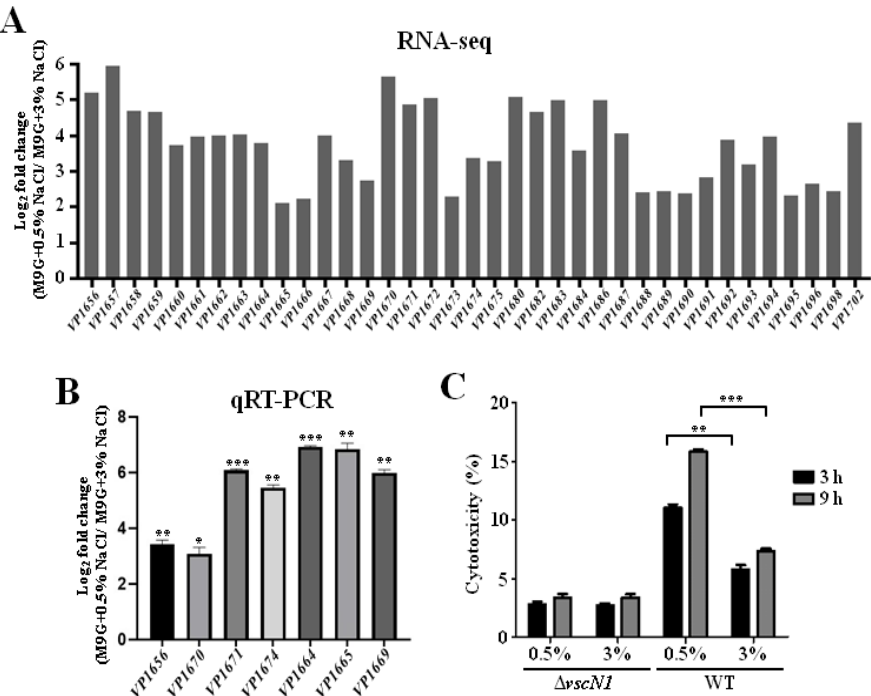
Figure 4. Low NaCl concentration induces the expression of T3SS1 and contributes to the cytotoxicity of V. parahaemolyticus to HeLa cells. ( A ) The transcription levels of T3SS1 identified by RNA-seq; ( B ) qRT-PCR analysis of the expression levels of T3SS1 genes in V. parahaemolyticus cultured in M9 medium with 0.5% NaCl compared to that in 3% NaCl. The data are presented as the mean ± SD ( n = 3). * p < 0.01, ** p < 0.001, *** p < 0.0001, Student’s t -test; ( C ) cytotoxicity analysis of WT cultured in M9 medium with 0.5% or 3% NaCl to HeLa cells. The data are presented as the mean ± SD ( n = 3). ** p < 0.001, *** p < 0.0001, Student’s t